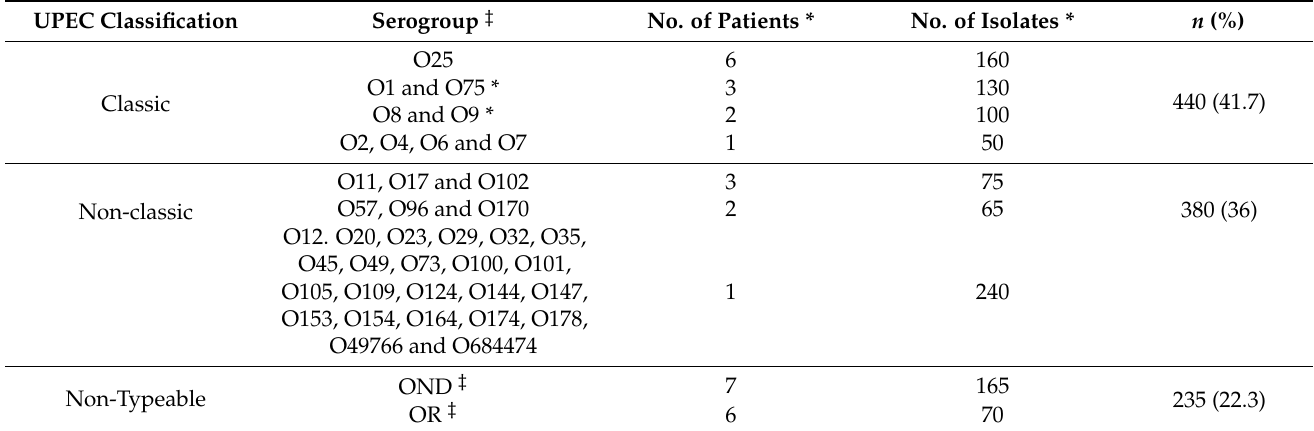
Table 1. E. coli serogroups identified in urine from patients with recurrent and persistent